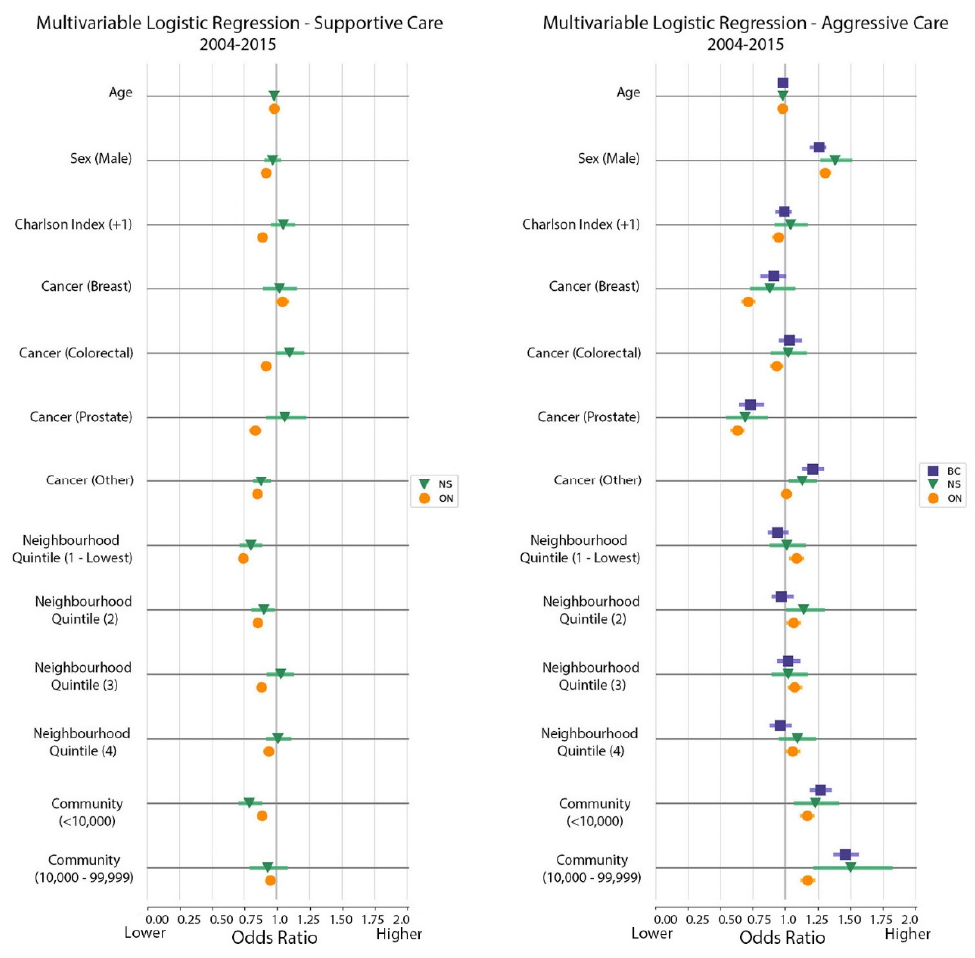
Figure 2. Multivariable logistic regression for supportive vs. aggressive care between 2004 and 2015. Reference odds ratio values are 1 for sex (female), Charlson Index (0 or missing), cancer type (lung), neighborhood income quintile (5 or highest), and community size ( ≥ 100,000).